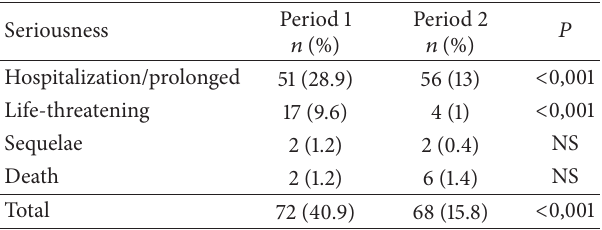
Table 4: Comparison of seriousness cases before and after integra- tion of PV-MTCP.